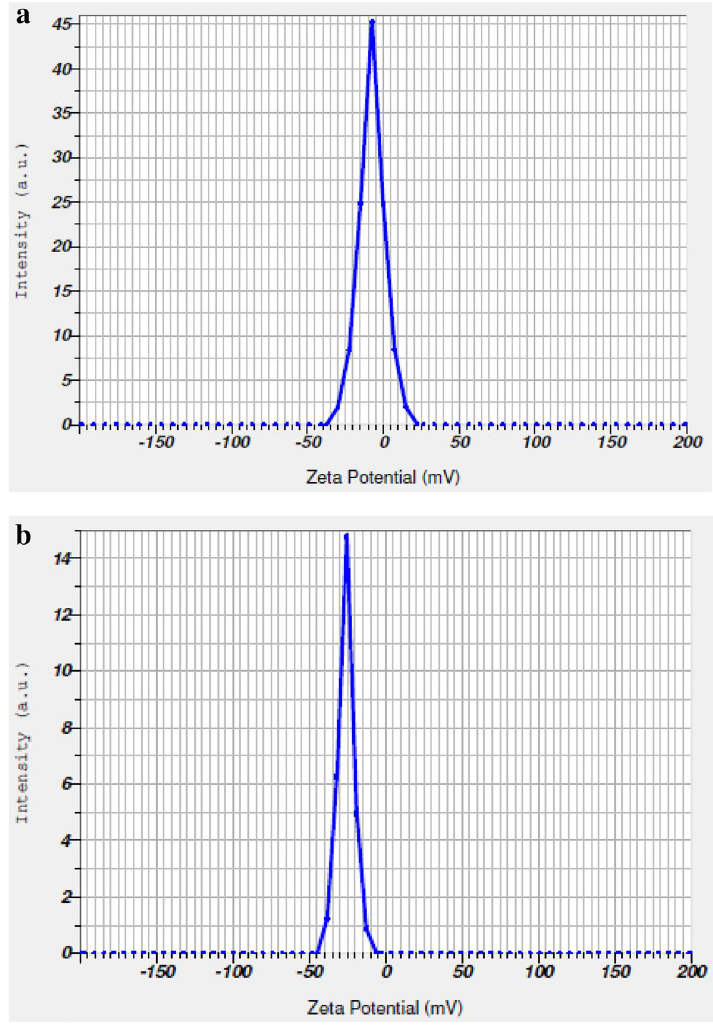
Figure 6. ( a ) Zeta potential of carbon sphere before loading Zn. ( b ) Zeta potential of carbon sphere after loading